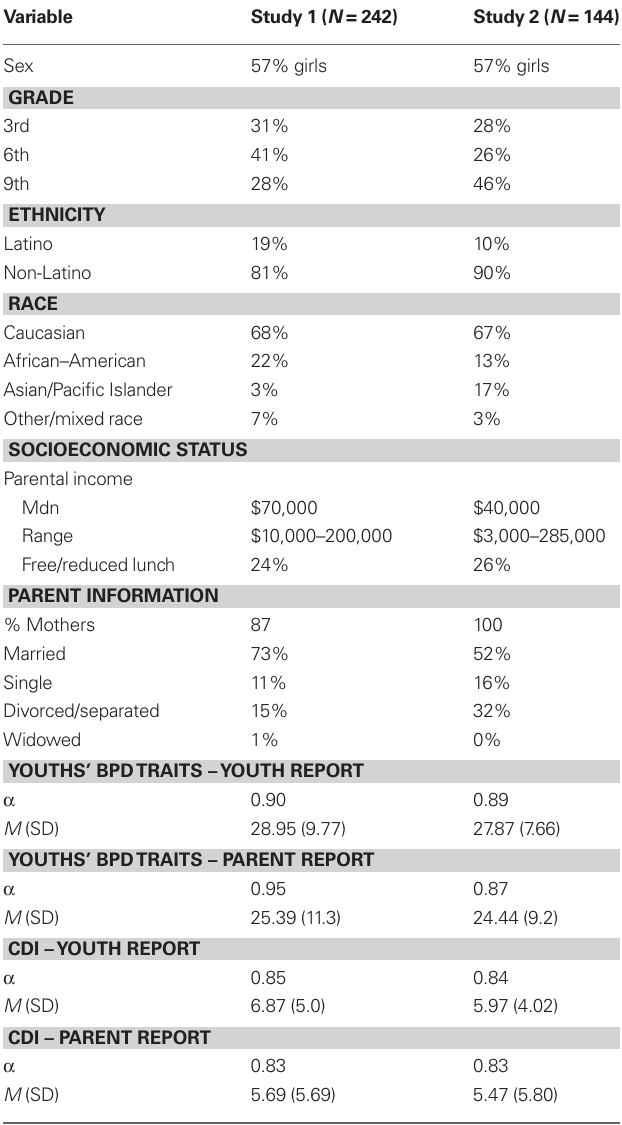
Table 1 | Descriptive statistics for samples 1 and